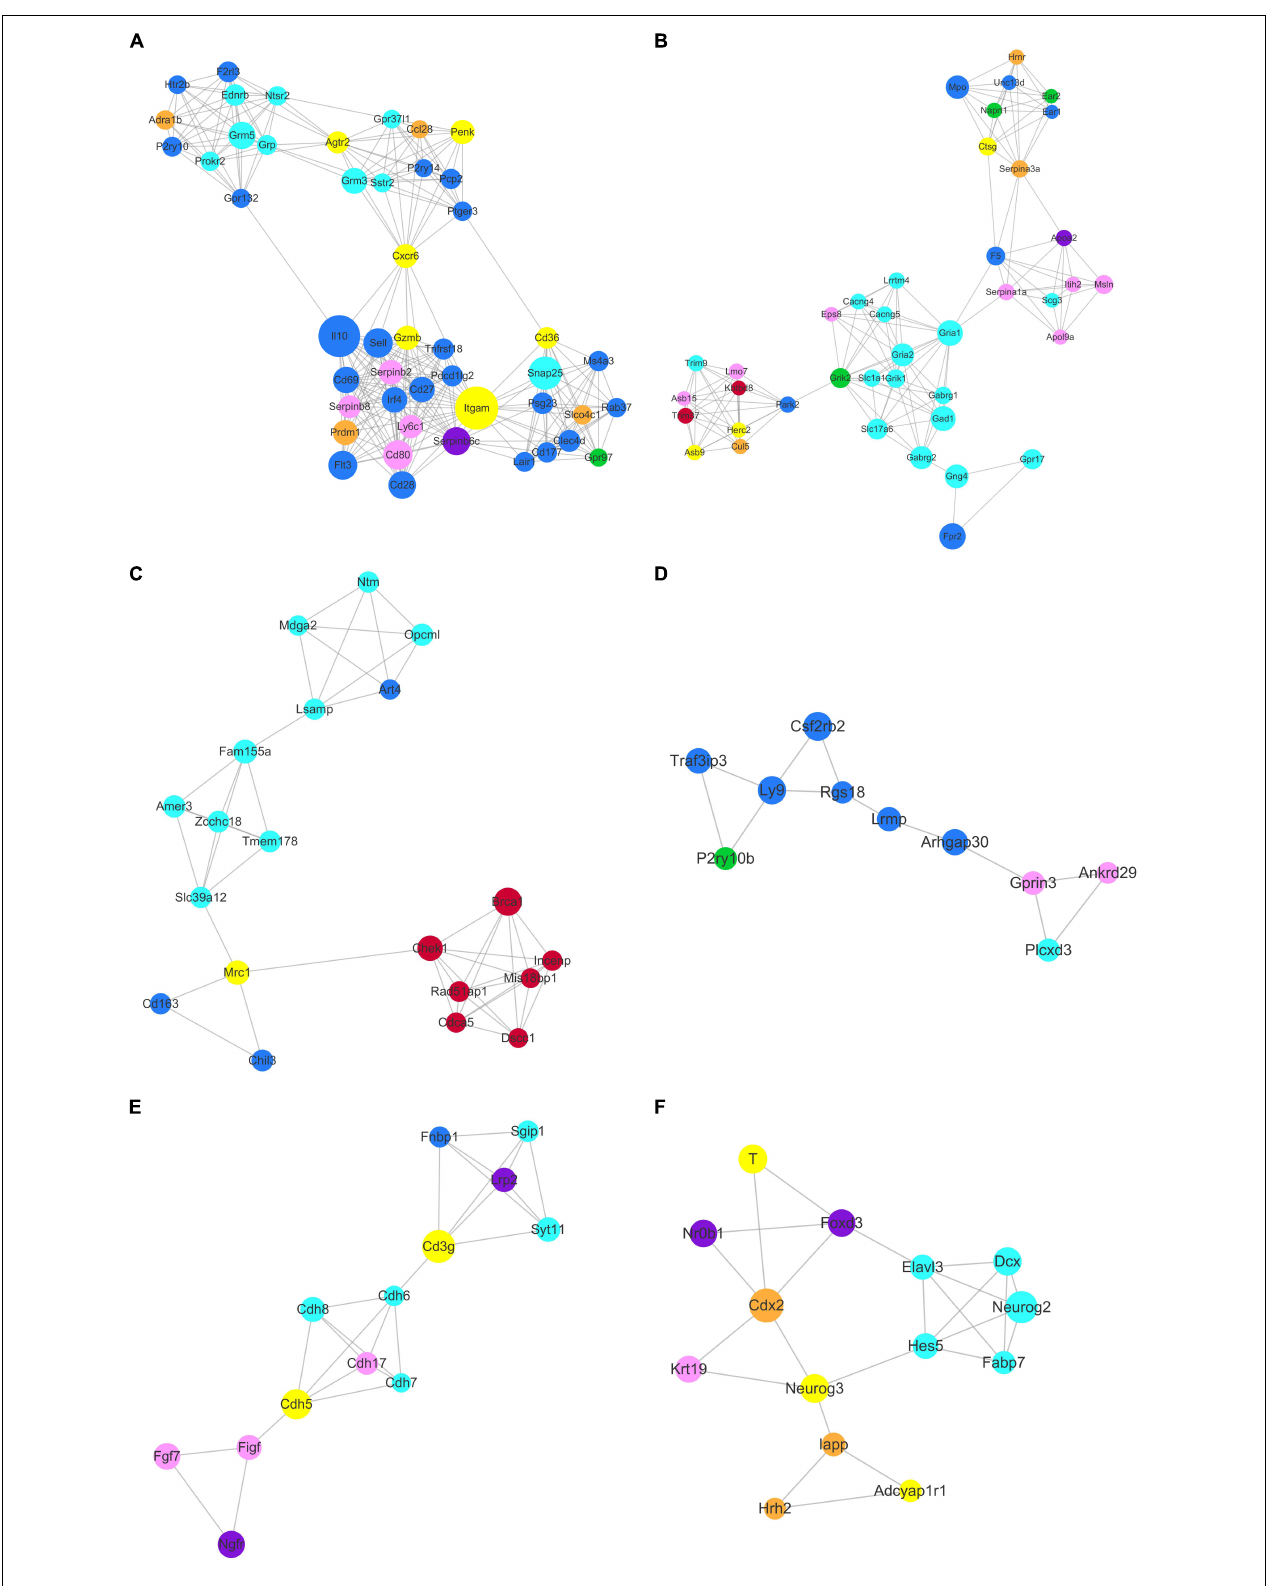
FIGURE 9 | Identification of six densely connected regions within the constructed stem cell correlated protein-protein interaction network based on the STRING database. Six densely connected regions were identified within the continued protein-protein interaction network by topology analysis (A–F) . The nodes are marked with the colors purple (ESC), brown (PGC), yellow (SSC), turquoise (NSC), pink (MSC), and blue (HSC) corresponding to the respective stem cell correlated modules.